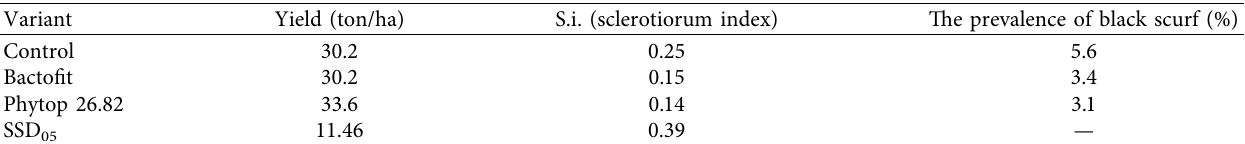
Table 3: The impact of the biopreparation Phytop 26.82 on the indicators of the development of black scurf on the root potato with a new yield of three